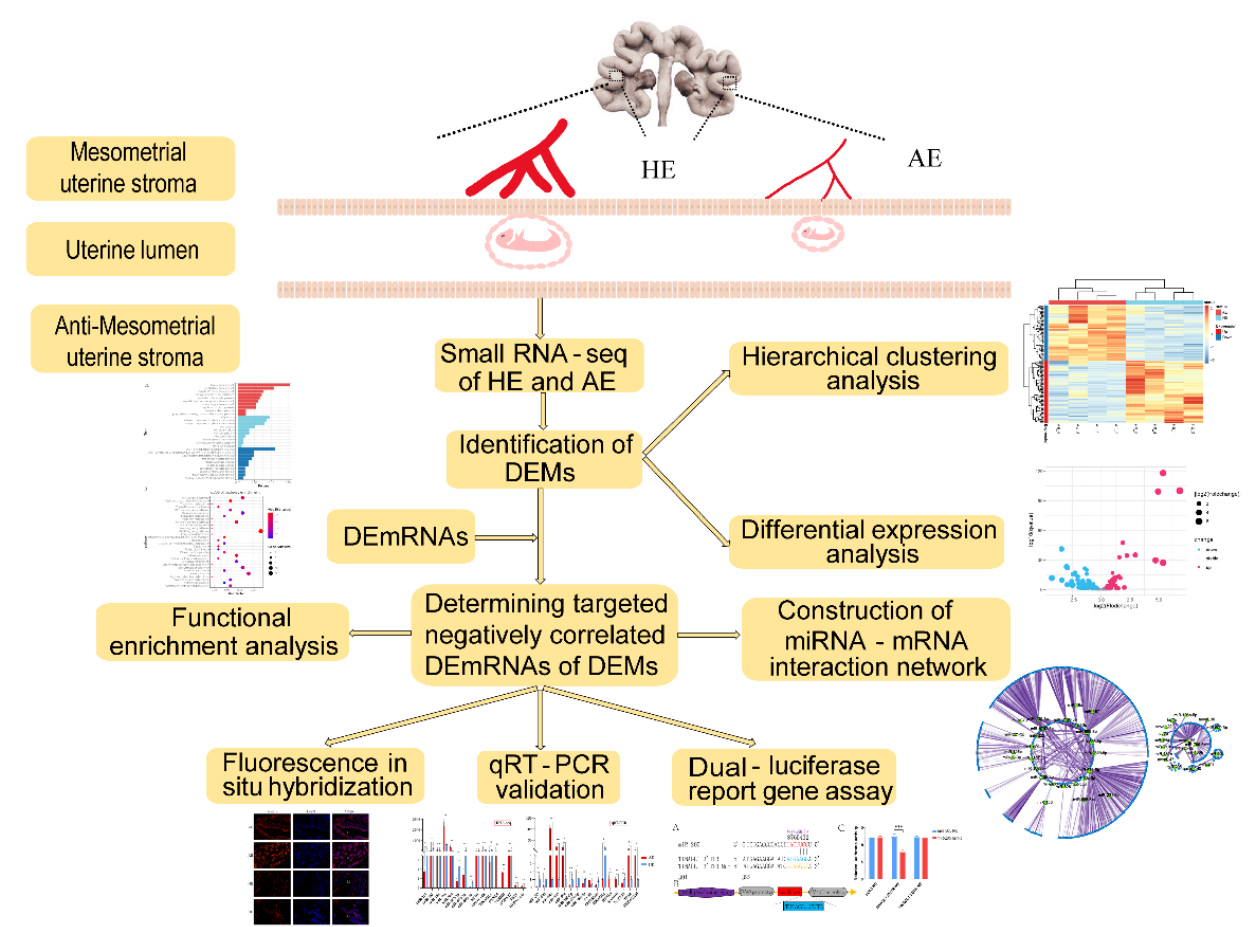
Figure 1. This flow chart displays the design ideas and experimental and analytical procedures of this study. The specific details are shown in the text.